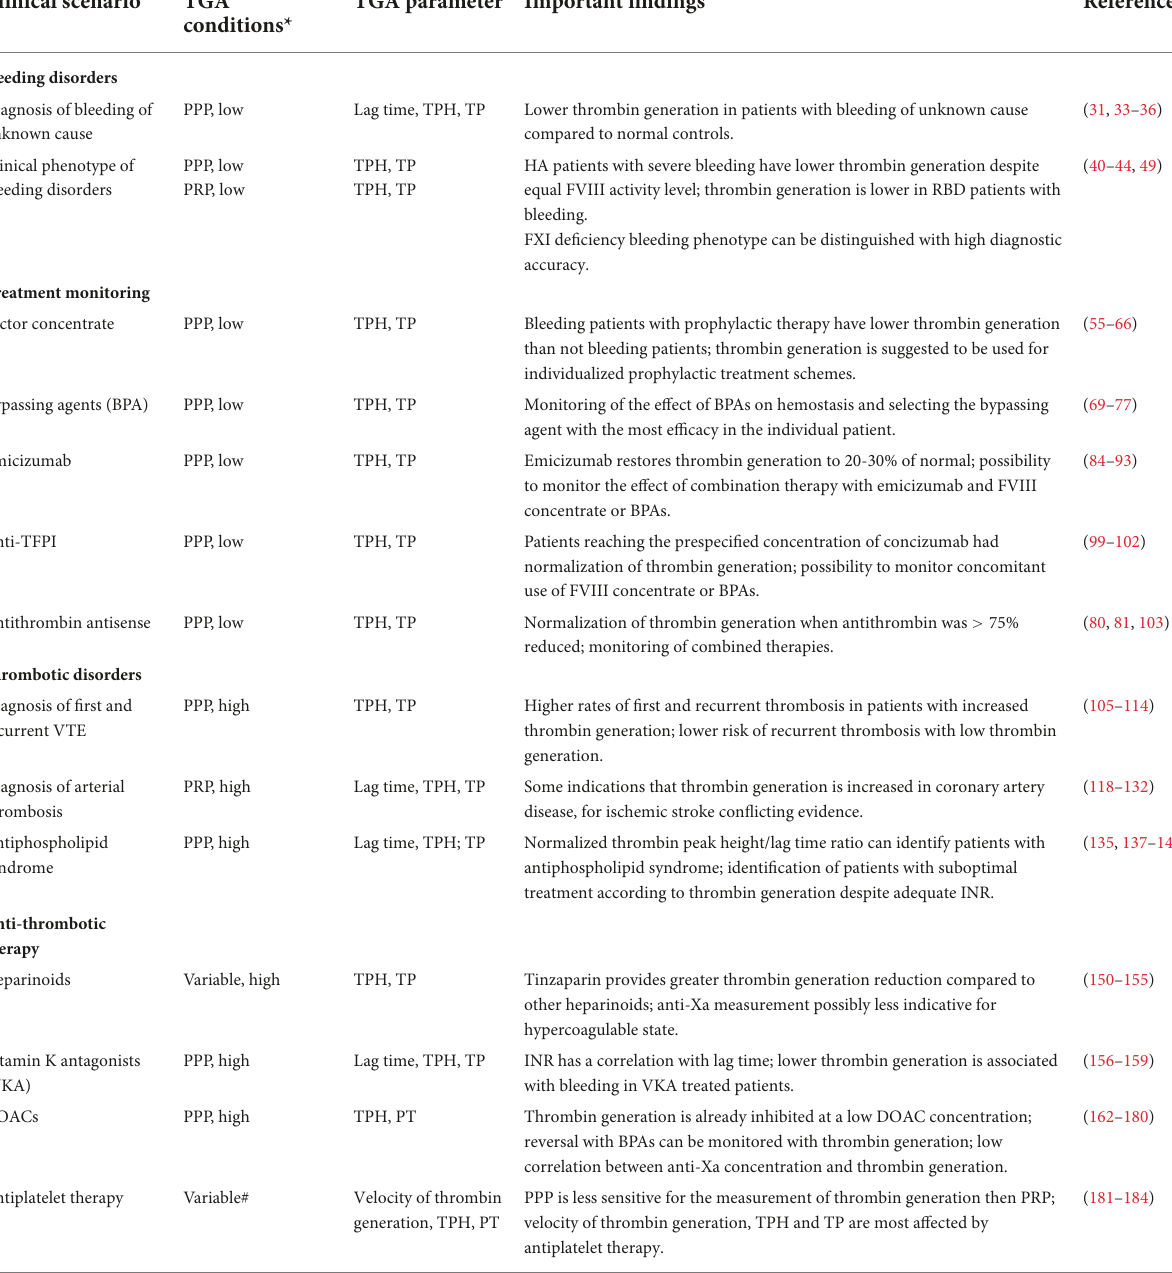
TABLE 1 Summary of thrombin generation assay characteristics and findings in bleeding and thrombotic